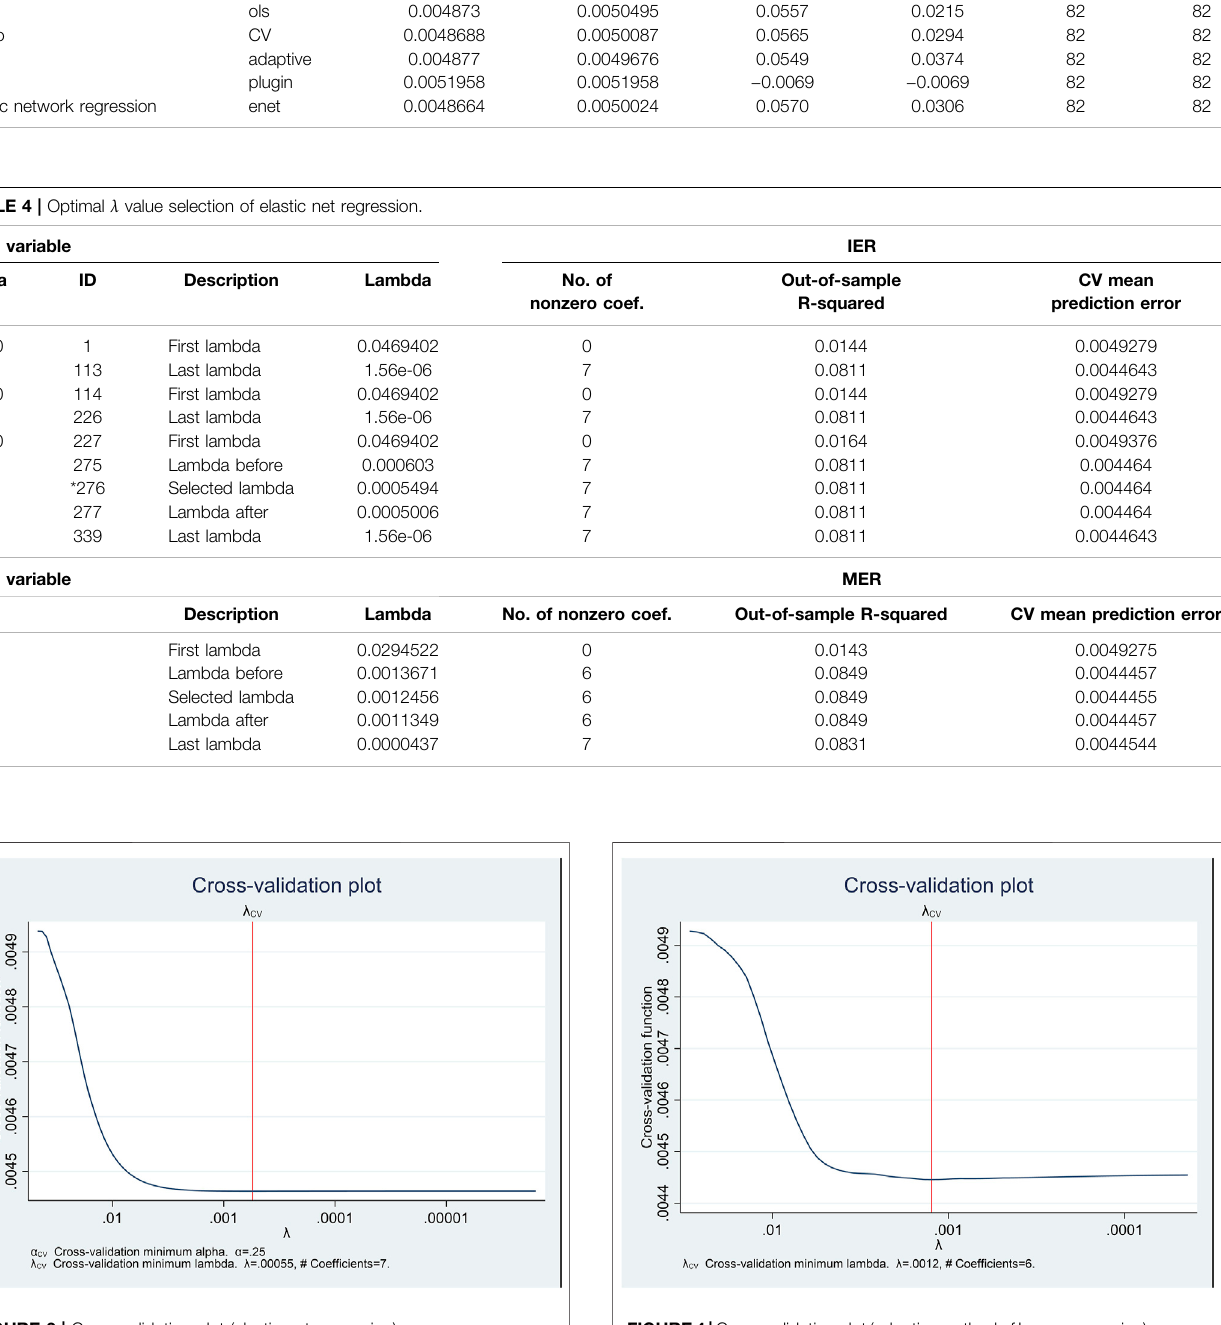
FIGURE 3 | Cross-validation plot (elastic net regression). FIGURE4|